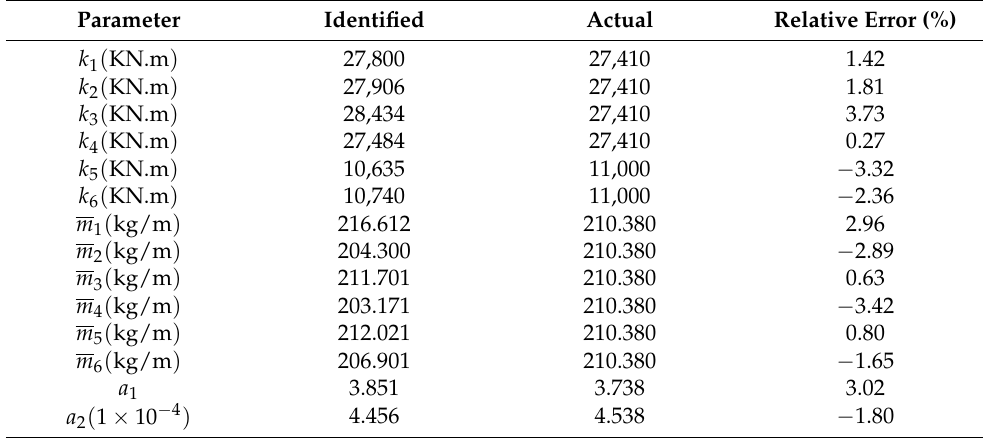
Figure 6. Parameter estimation results for the plane frame. ( a ) Convergence of identified linear density m 4 ; ( b ) convergence of identified linear density m 5 ; ( c ) convergence of identified linear stiffness k 4 ; ( d ) convergence of identified linear stiffness k 5 ; ( e ) convergence of identified dumping coefficient a 1 ; ( f ) convergence of identified dumping coefficient a 2 . Table 2. The parameters identification results of the plane